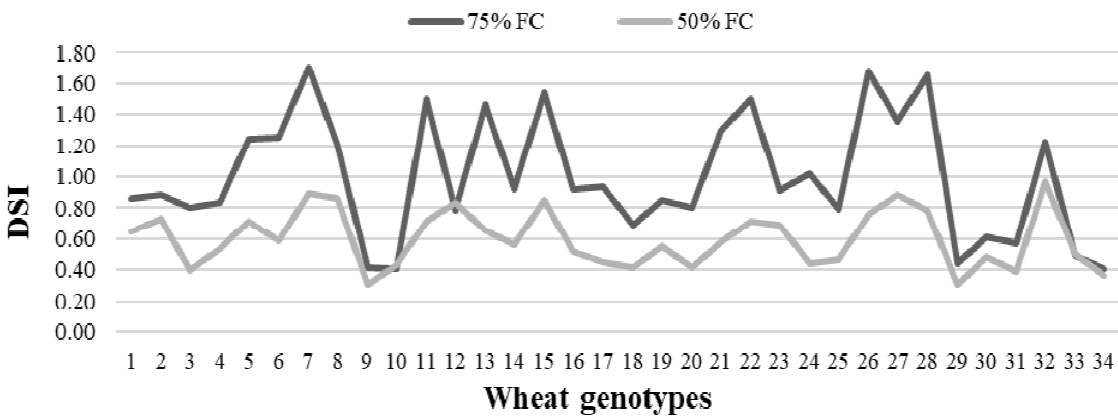
Fig. 2. Drought susceptibility index (DSI) of thirty-four wheat genotypes under different levels of water deficit